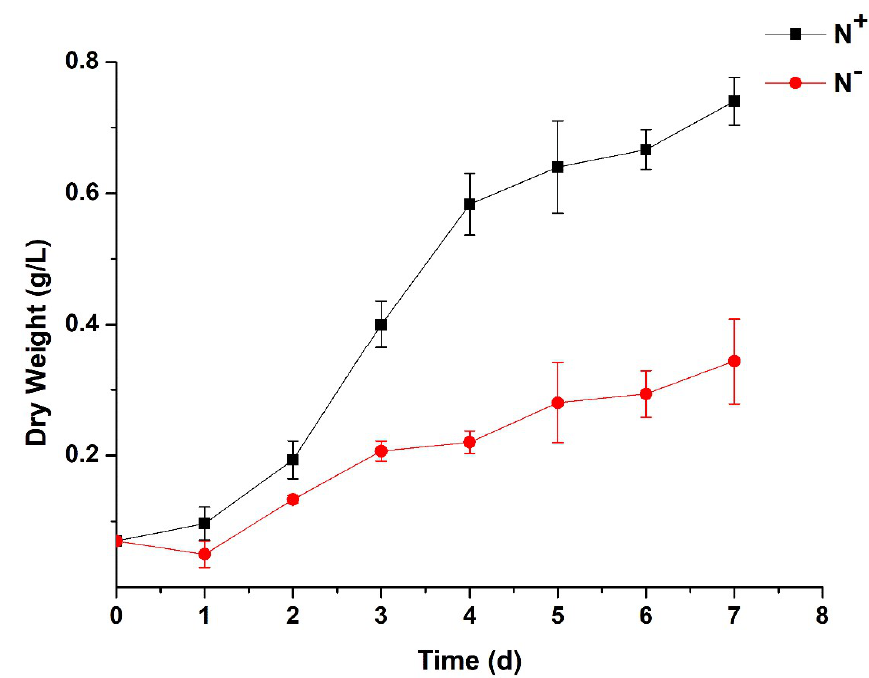
Figure 2. Dry weight comparison between Parachlorella kessleri TY02 grown under N + and N − . Data are shown as mean ± SE. n = 3.